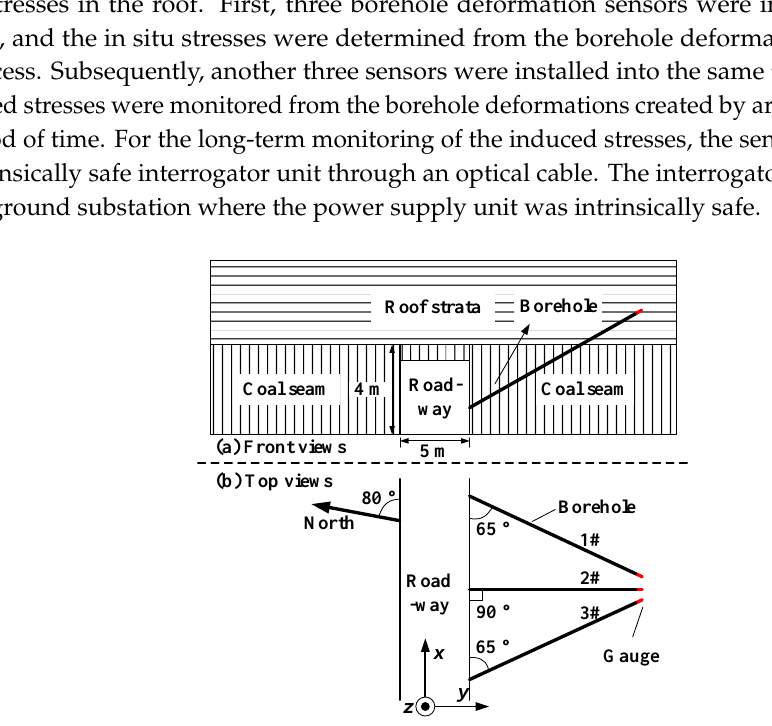
Figure 13. The layout of three boreholes and the local coordinate system.